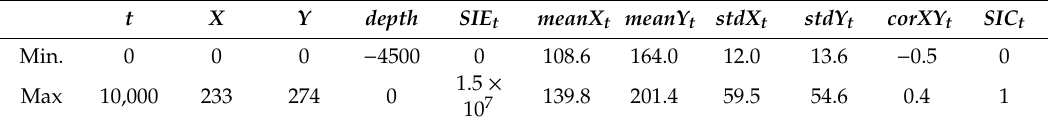
Table 1. Minimum and maximum value of input factors.